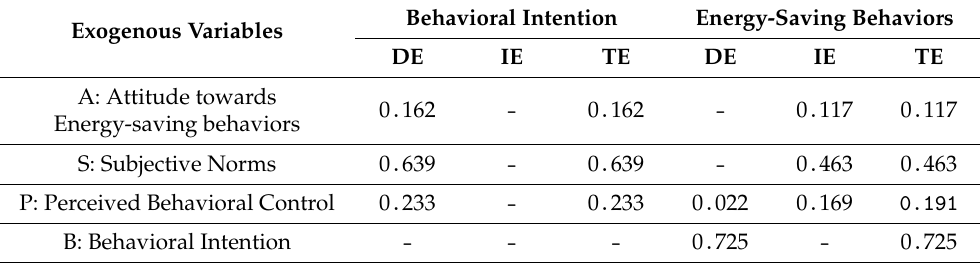
Table 5. Direct, indirect, and total effects of exogenous variables on endogenous